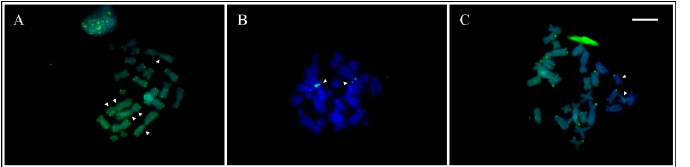
Fig 5. Interstitial telomeric sequences (ITS) in Lophyohylini. Metaphase plates showing ITS detected with FISH with telomeric DNA probe (using FITC fluorochrome). A. Phyllodytes edelmoi . B. Phyllodytes melanomystax . C. Osteocephalus buckleyi . The white arrowheads indicate the ITS. It should be noted that in order to improve the detection of ITS in P . melanomystax , the distal telomeric signals are not visualized in the metaphase shown in ( B ).